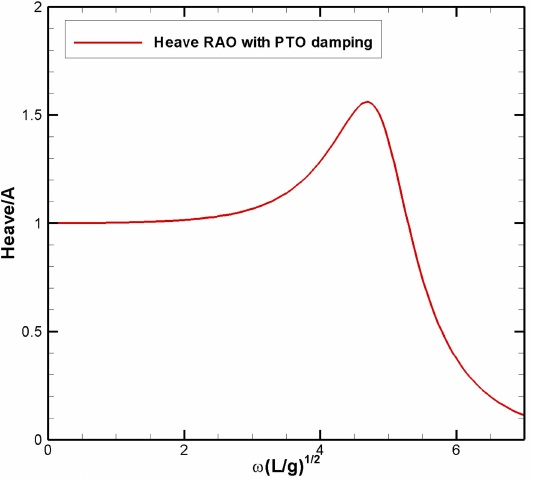
Figure 4. Heave RAO of the HPA applied with the optimal PTO damping